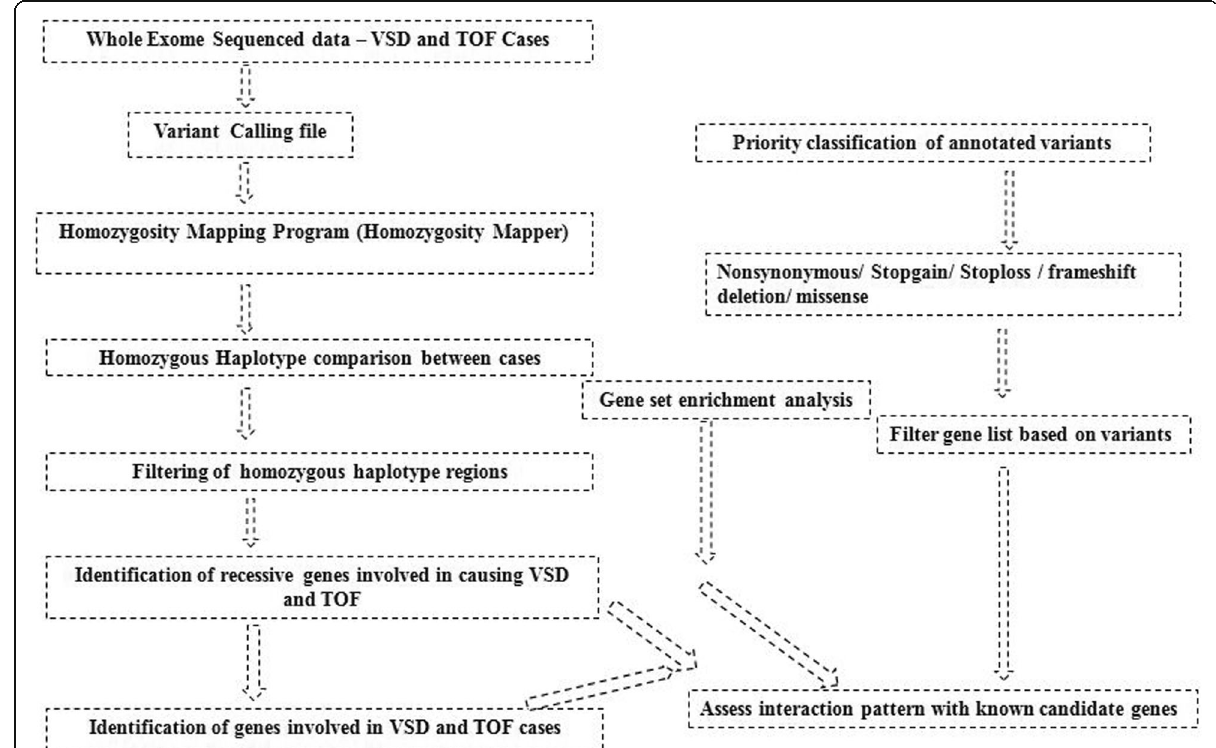
Fig. 1 Workflow for identification of homozygous blocks and candidate genes. Whole-exome data (variant calling file) is used for homozygosity mapping. Homozygosity mapper is integrated with gene distillers to search for candidate genes and sort the genes in the candidate